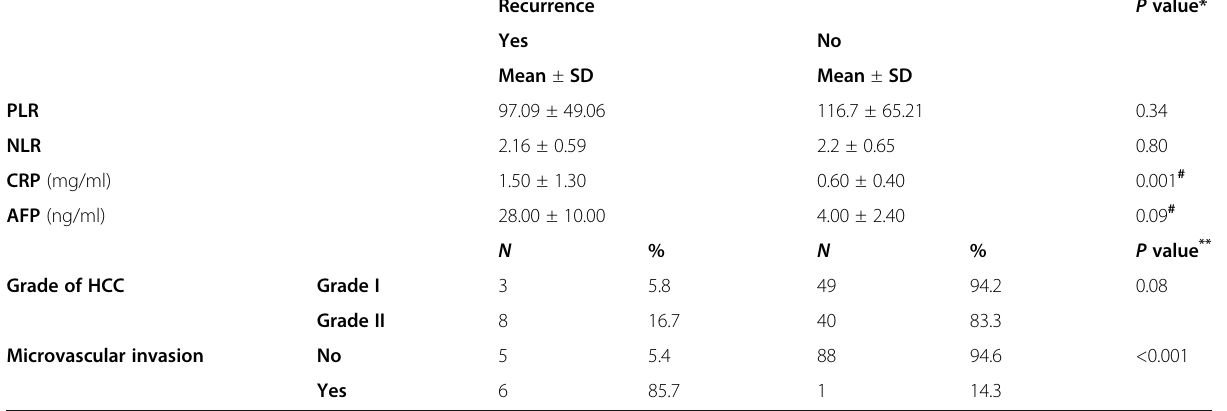
Table 3 The relation between post-transplantation data and HCC recurrence